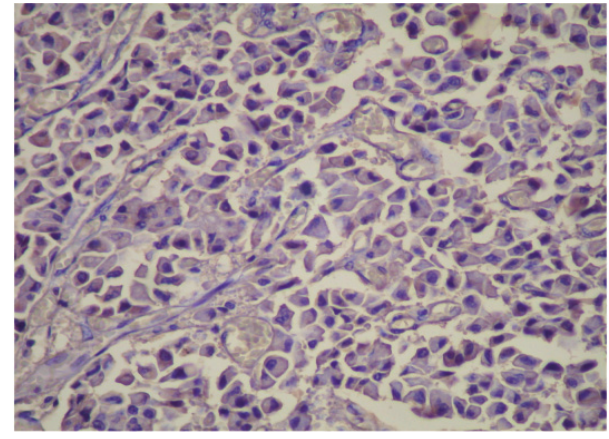
Figure 4 - Immunohistochemistry of the pancreatic tumor showing serotonin-positive expression in neoplastic cells (immunoperoxidase,